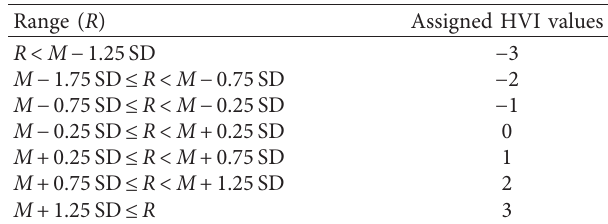
Table 3: Assigning HVI values to results of EWA and